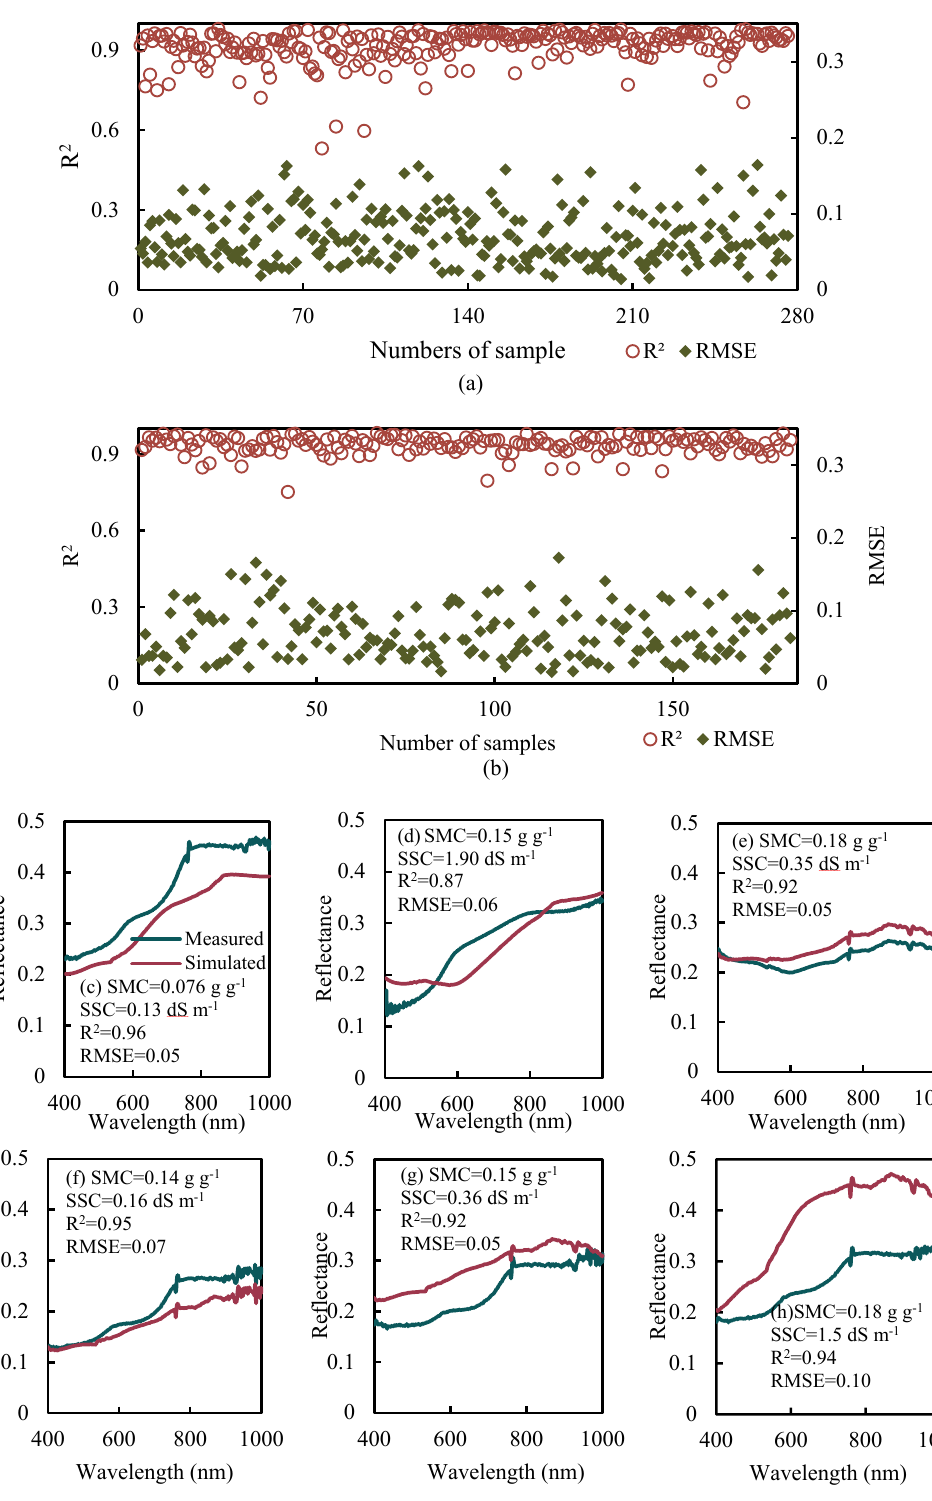
Figure 11. Comparison of simulated reflectance based on MT-SSREM with measured reflectance: ( a ) simulation accuracy of calibration dataset; ( b ) simulation accuracy of validation dataset; ( c − e ) measurement and simulation of wet-soil reflectance from calibration dataset and ( f − h ) from validation dataset.